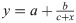
Population and individual cell fitness of E. coli (lacI− B REL606) in varying growth conditions.(A) Mean ± SEM (N = 3) growth rate (p < 10−6 for no trend in lactose concentrations > 1 mg/ml) and fraction of propidium iodide-stained (PI+) cells (p = 0.0051 for no PI+ trend in lactose concentrations > 1 mg/ml) at various lactose concentrations. Dashed lines indicate quadratic regression models, which fit significantly better than do linear models (see text for details). PI+ fractions at low lactose concentrations are shown in S4c Fig. (B) Mean ± SEM (N = 3) expression of GFP at various lactose concentrations (p = 0.00016 for no trend). CV, coefficient of variation (p < 10−6 for no trend). Dashed lines indicate fits of statistical models used as a guide to the eye (fitted model is: y=a+bc+x). (C) PI-stained E. coli grown in a microfluidic device perfused with the indicated concentration of lactose (mg/ml). Note the patchy distribution of fast growing (low GFP) and slow- or non-growing (high GFP) cells at 50 mg/ml lactose. Brightfield alone is shown below. PI staining identifies dead cells and appears red or yellow, depending on the amount of GFP in the same cell. Dark spots are silicone support structures.